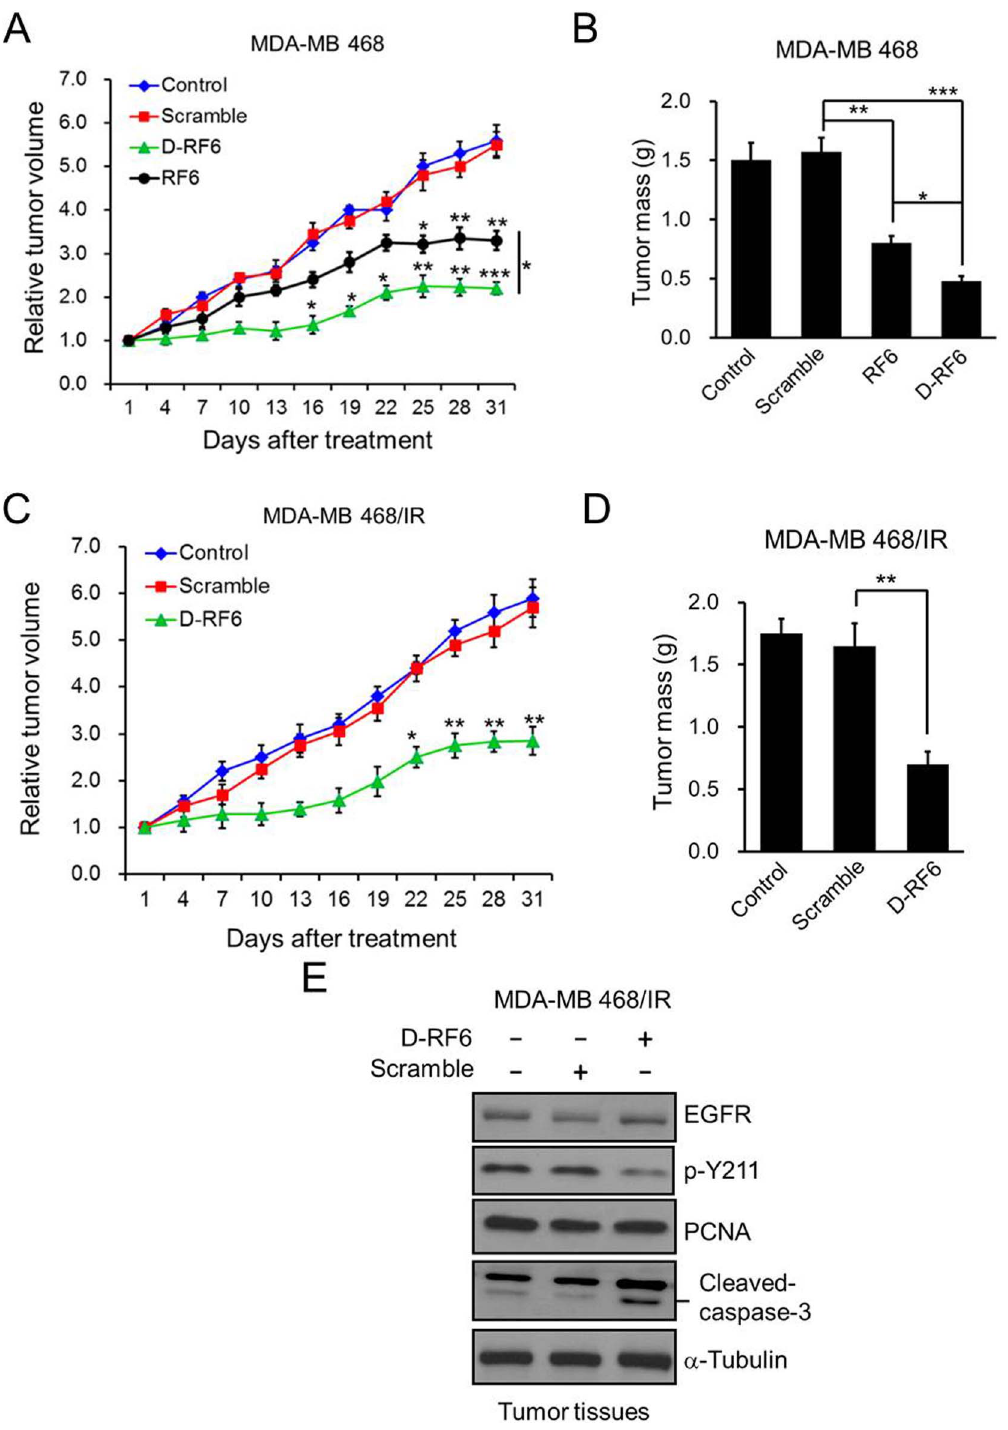
Figure 5. The effect of CPPP on tumor growth invivo . (A) Approximately 1 6 10 7 MDA-MB 468 cells were subcutaneously injected into the flanks of nude mice. When the tumors were palpable, mice were randomly divided into 4 groups and treated with PBS (Control), scrambled peptide for RF6 (Scramble), RF6 CPPP, or D-RF6 CPPP (200 nmol/mouse) by intratumoral injection. Tumor volume was measured the tumor volume at the indicated time point. (B) The weight of each of the harvested tumors from (A) was measured after treatment. (C) Approximately 1 6 10 7 Iressa-resistant MDA-MB 468 (MDA-MB 468/IR) cells were injected into the mammary fat pad on either side of SCID mice. When the tumors were palpable, mice were randomly divided into 3 groups and treated with PBS (Control), scrambled peptide for D-RF6 (Scramble), or D-RF6 CPPP (200 nmol/mouse) by intratumoral injection. Tumor volume was measured the tumor volume at the indicated time point. (D) The weight of each of the harvested tumors from (C) was measured after treatment. The curves and bars indicate mean 6 S.D.; *, p , 0.05; **, p , 0.01; ***, p , 0.001 by t -test. (E) Extracted tumor tissue lysates from (D), the protein levels of EGFR, p-Y211, PCNA and cleaved-caspase-3 were determined by IB.